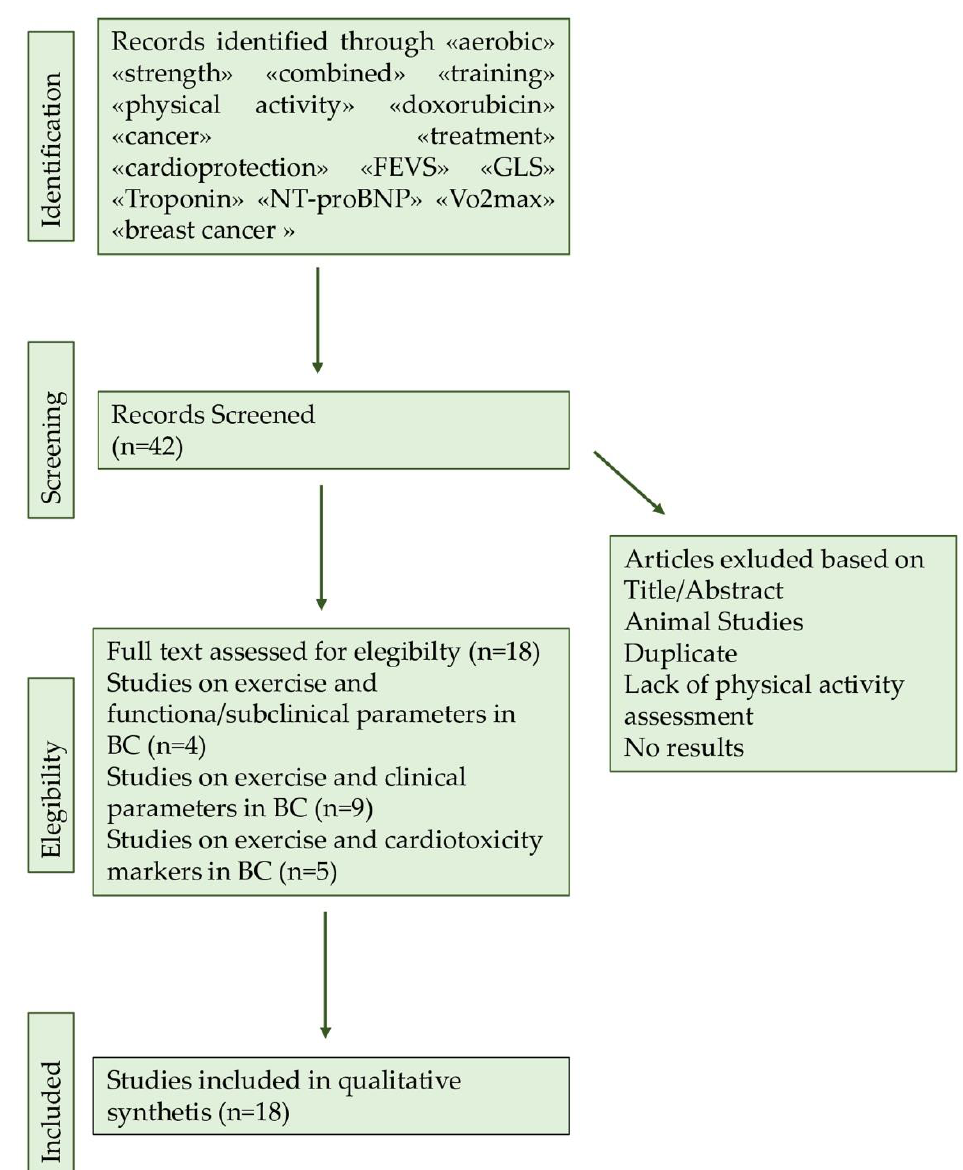
Figure 3. Flowchart of searching methods.